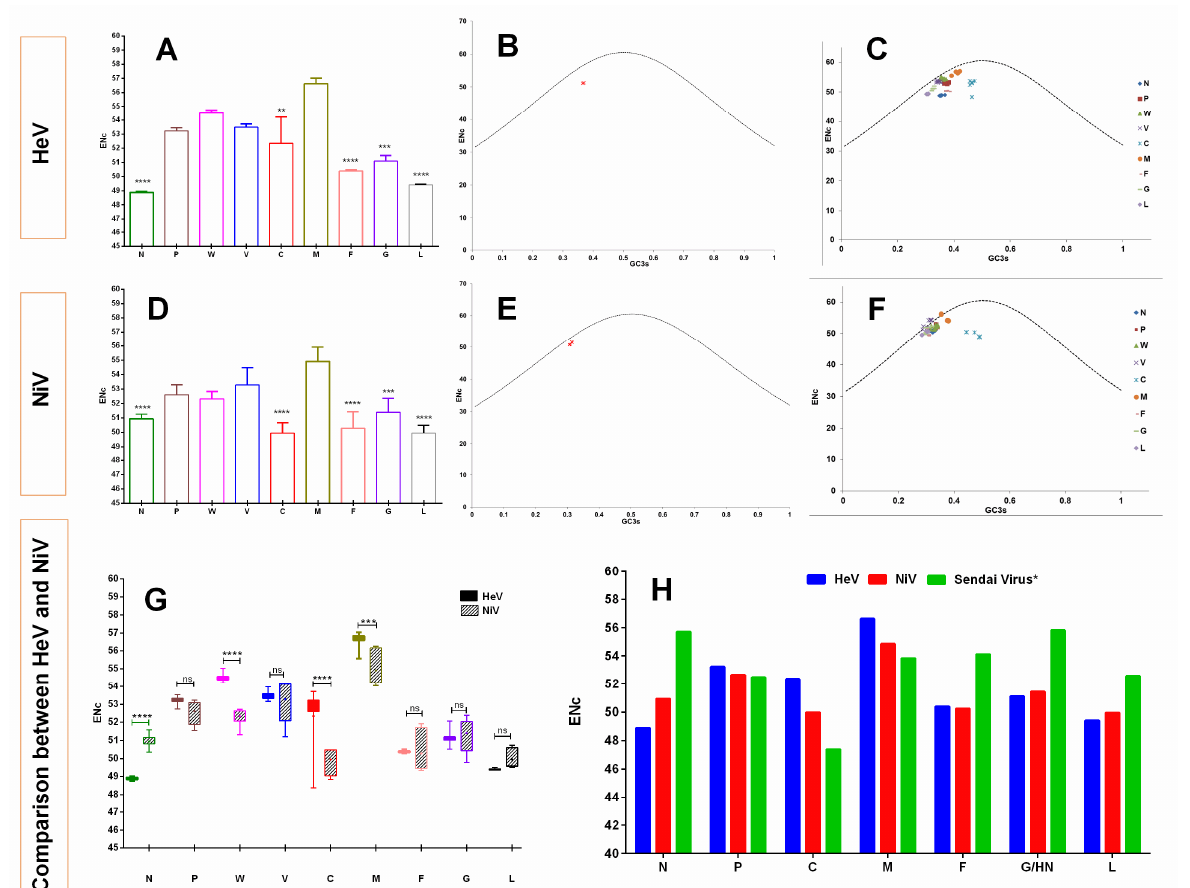
Figure 4. Differential codon bias on the coding sequences of henipaviruses. The gene-wise ENc values for HeV ( A ) and NiV ( D ) are presented. The Kruskal-Wallis test was used to see any evidence of significant differences. The ENc–GC3s plots for the complete coding sequences of HeV ( B ) and NiV ( E ) are shown. The standard curve (functional relations between expected ENc and GC3s), where the codon usage bias was determined by the GC3s composition only is denoted by a dotted line. Similarly, ENc–GC3s plots for the individual protein-coding sequences of HeV ( C ) and NiV ( F ) are also shown. G depicts a comparison of the ENc values among the different proteins encoded by HeV and NiV. The two-way analysis of variance (ANOVA) with Tukey’s honestly significant difference test was used to see any evidence of significant difference. H represents the ENc values comparison of HeV, NiV, and Sendai virus (distantly related). Note: Error bars denote the standard deviation (SD). **** p < 0.0001; *** p < 0.001; ** p < 0.01; ns—non-significant.